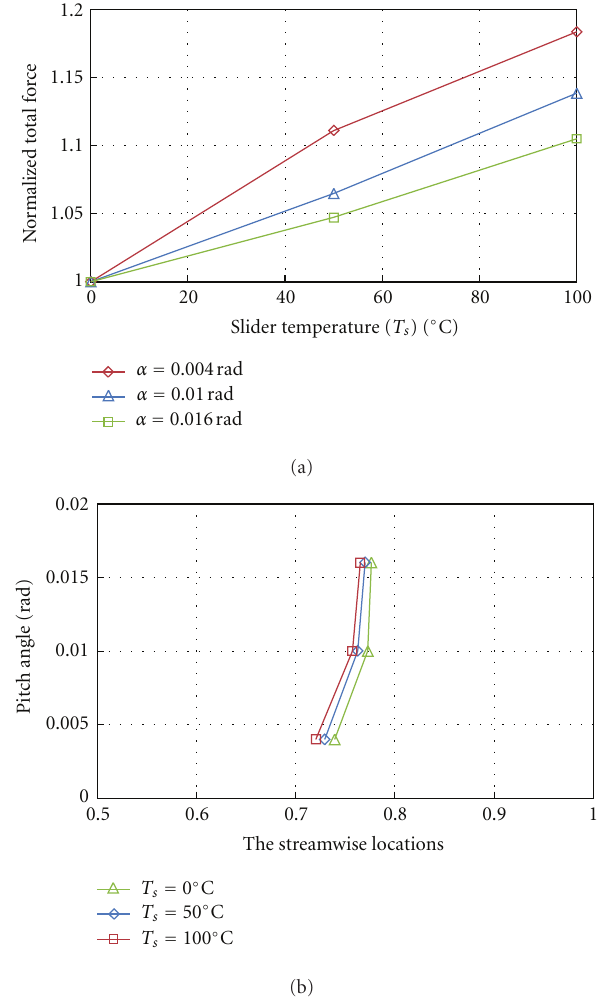
Figure 10: The variations of (a) total bearing force acted on the slider surface and (b) positions of resultant force with varied slider temperatures for di ff erent pitch angles. The normalized total force represents the respective total force divided by the total force resulted from the test with T s = 0 ◦